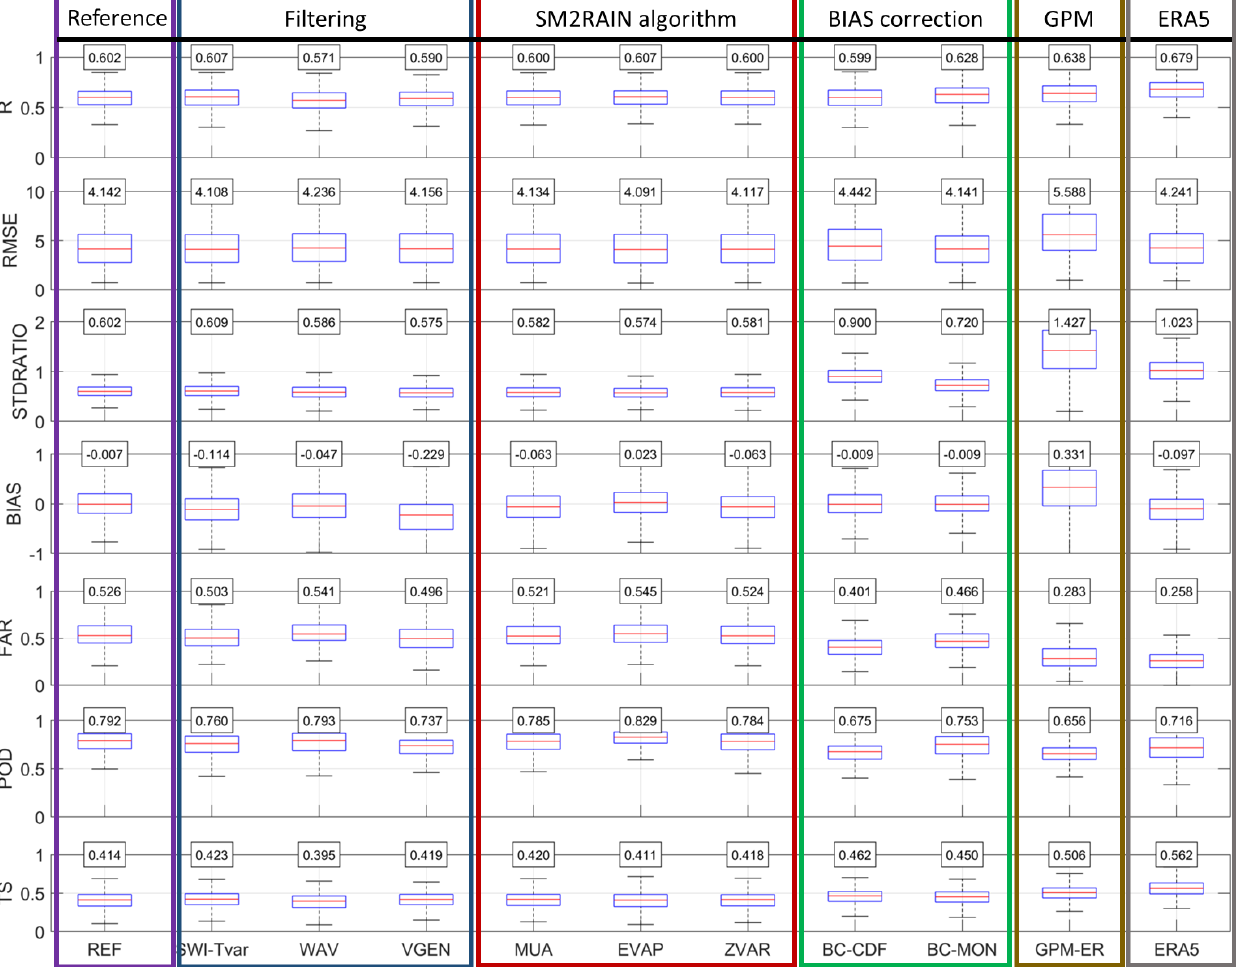
Figure 3. Performance at 1009 points in terms of Pearson’s correlation, R (–), root mean square error, RMSE (mmd − 1 ), the variability ratio, STDRATIO (–), the mean error between estimated and reference rainfall, BIAS (mmd − 1 ), the false alarm ratio, FAR (–), the probability of detection, POD (–), and the threat score, TS (–). For details about the different configurations see Table 2 (GPM-ER: GPM IMERG Early Run